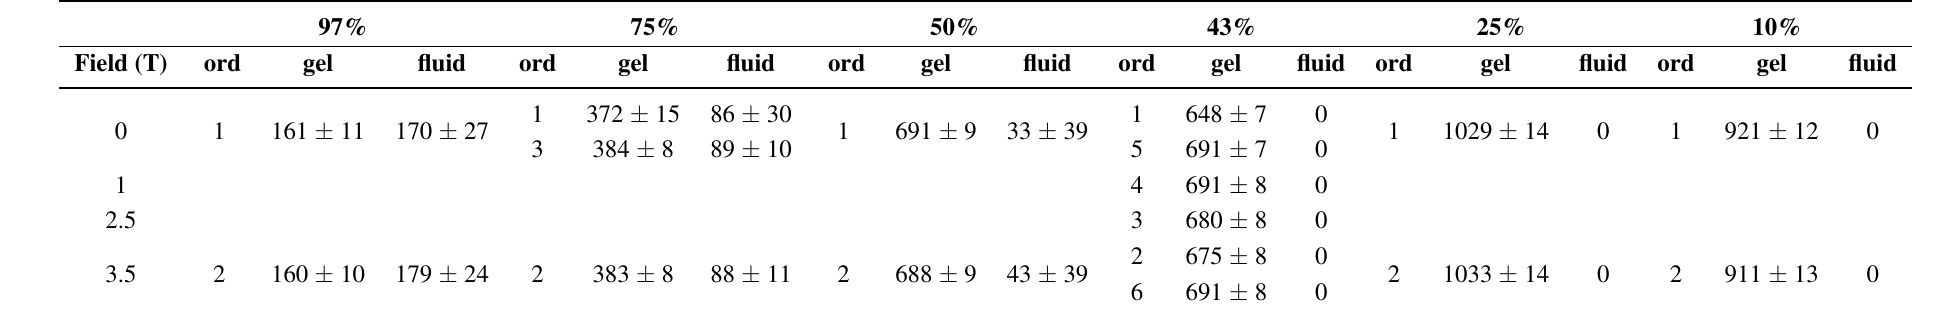
Table 2. Integrated intensities from fitting Lorentzian peak profiles to the gel and fluid acyl chain correlation peaks in Figure 4 for all samples. The order of the corresponding field exposure protocol is also given